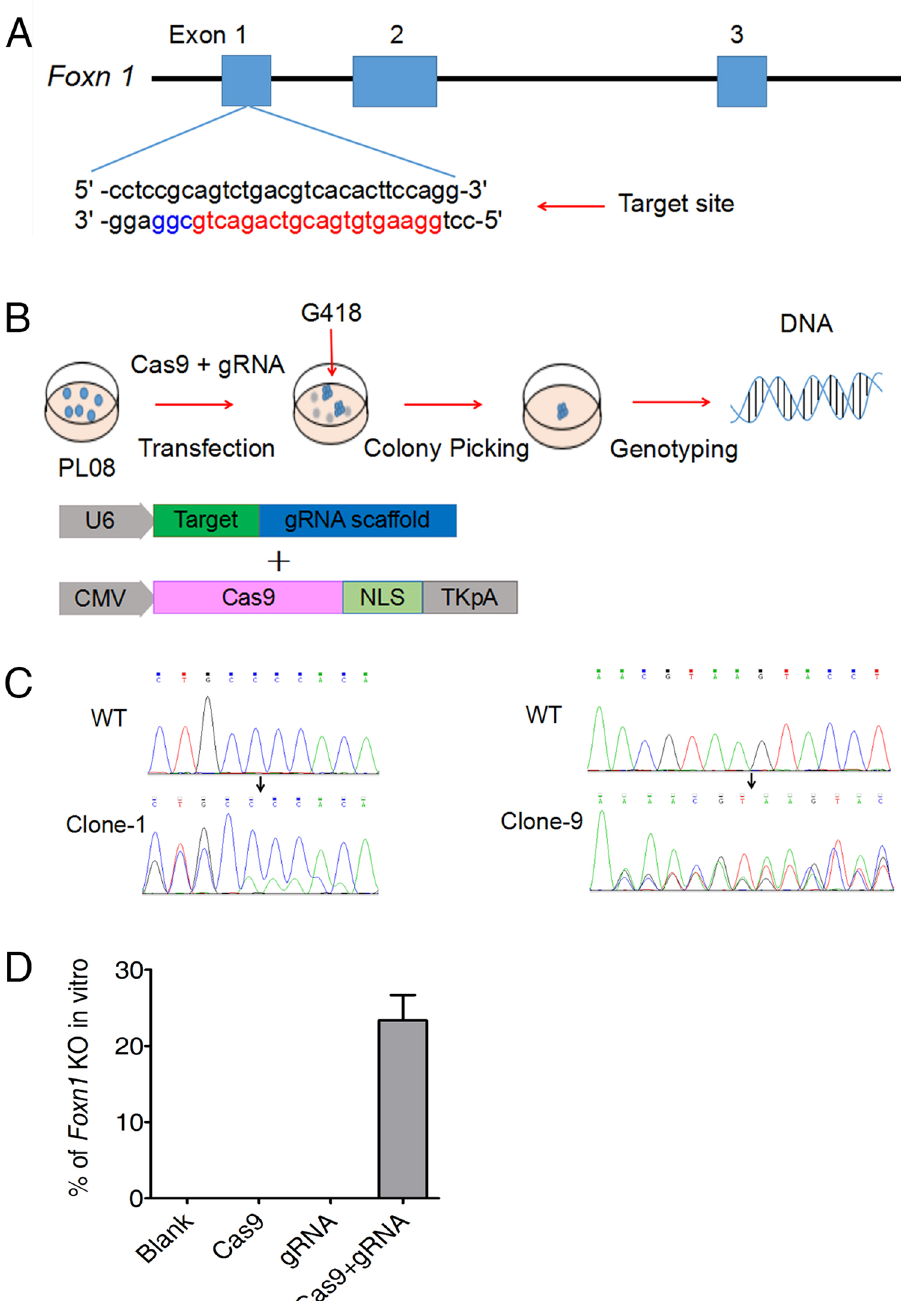
Figure 1. Foxn1 gene targeting in PL08 cells using a type II CRISPR system in vitro . ( A ) Schematic of the Cas9/sgRNA-targeting site in exon 1 of Foxn1 . The sgRNA-targeting and protospacer-adjacent motif (PAM) sequences are labeled in red and blue, respectively. ( B ) Schematic of Foxn1 gene targeting in PL08 cells in vitro . PL08 cells were transfected with U6- Foxn1 -sgRNA vector and pcDNA3.3-hCas9 plasmid. Abbreviations: U6 = U6 polymerase III promoter; CMV = cytomegalovirus promoter; NLS = nuclear localization signal; TK = thymidine kinase; pA = polyadenylation signal. In the plate wells, living cells are shown in blue, and dying cells are shown in gray. ( C ) Genotyping of Foxn1 -targeted and wild-type (WT) PL08 cells. Clones 1 and 9 are shown. The target exon 1 of Foxn1 was amplified by PCR and then analyzed using DNA sequencing. Double sequencing peaks in clone 1 showed mutant alleles. The three sequencing peaks in clone 9 may originate from a mixture of two different clones. ( D ) Efficient knock-out of the Foxn1 gene in PL08 cells by co-transfection with U6- Foxn1 -sgRNA vectors and pcDNA3.3-hCas9 plasmids. The percentages indicate Foxn1 -knock-out clones in different groups. The data are representative of three independent experiments. Twenty clones were selected and analyzed in each